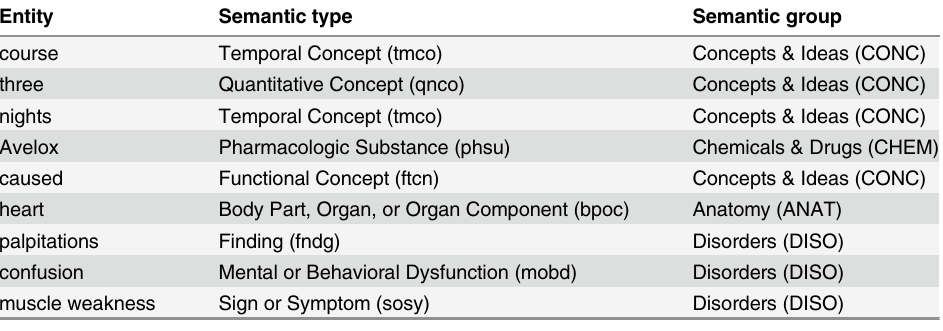
Table 2. An example of entities extracted by MetaMap from a drug